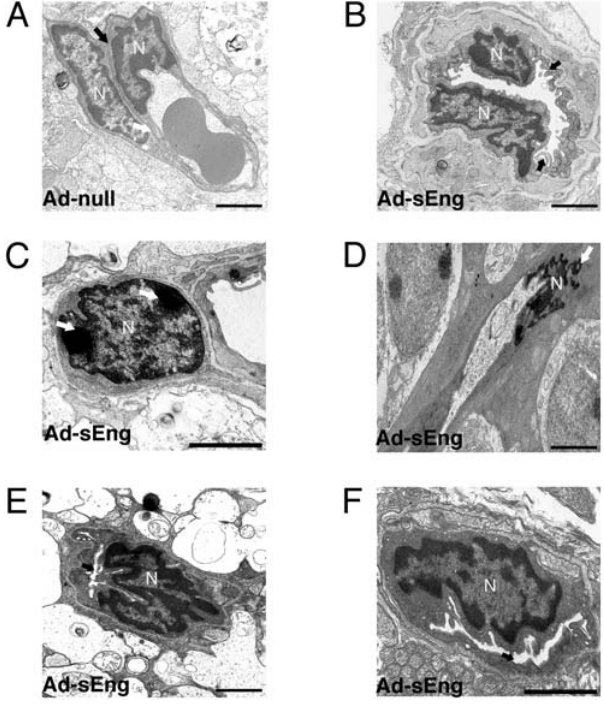
Figure 7. Ultrastructure of retinal vasculature following inhibition of TGF- b . (A) TEM micrograph of a microvessel in the ganglion cell layer from a retina of a control mouse expressing Ad-null (day 14). Nuclei of an EC and pericyte are apparent, with a defined basement membrane (arrow). (B)–(F) TEM micrographs of the retinal vessels from mice expressing Ad-sEng. (B) The lining of some ECs appeared ‘ruffled’ with finger-like processes protruding into the luminal space and multiple vacuoles within the cytoplasmic space (arrow). Nuclear condensation characteristic of apoptosis was apparent in some (C) pericytes and (D) ECs (arrows). (E) (F) Numerous vessels in the inner retinal layers displayed significant reductions in luminal diameter (arrows). (A)–(F) Scale=2 m